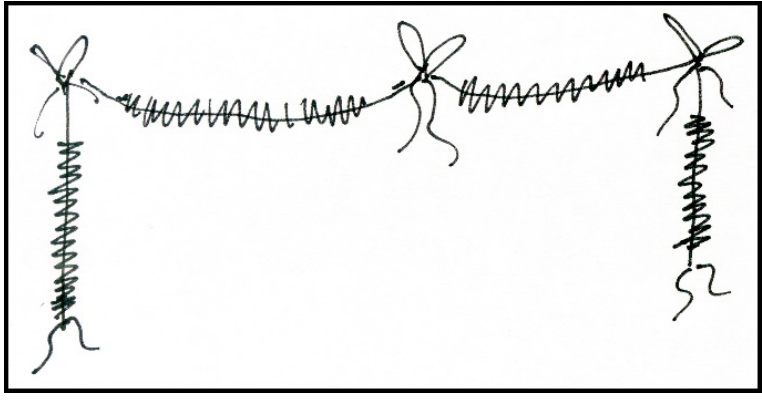
Figure 5. Drawing of hanging garland (Drawing by author).